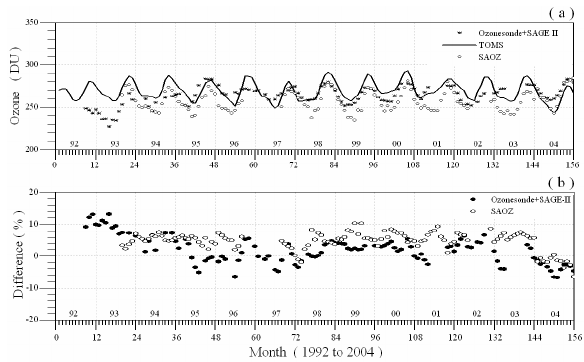
Fig. 8. (a) Monthly mean evolution of integrated ozone values ob- tained for the period from 1992 to 2004 by TOMS, OAS and SAOZ (a) Monthly mean evolution of integrated ozone values obtained for the period from measurements. (b) The normalized percentage of difference ob- 1992 to 2004 by TOMS, OAS and SAOZ measurements. tained from OAS and SAOZ measurements with respect to (b) The normalized percentage of difference obtained from OAS and SAOZ measurements with respect to TOMS.